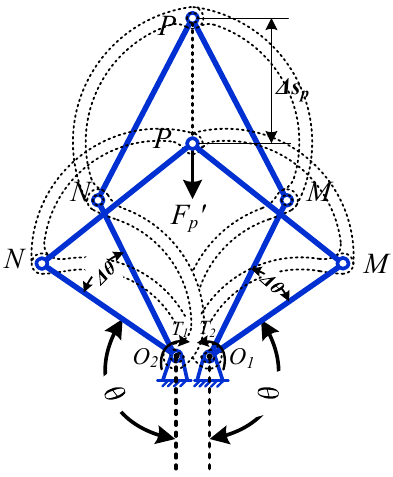
Figure 6. Mechanical analysis of the expanding arm.